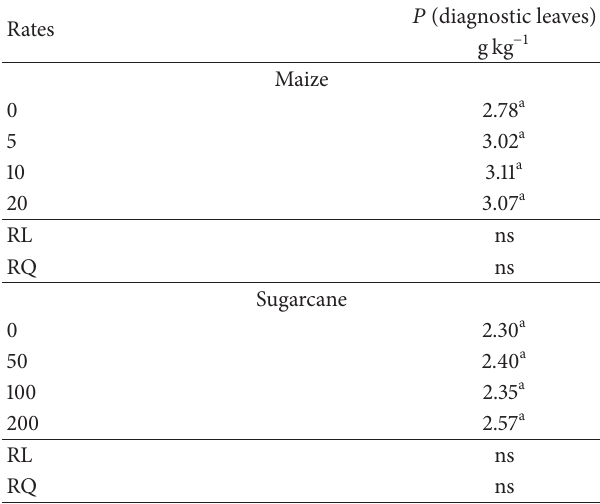
Table 1: Phosphorus concentrations in diagnostic leaves of maize plants grown in a Typic Eutrorthox amended annually with sewage sludge for 13 consecutive years and in diagnostic leaves of sugarcane plantsgrowninaTypicHapludalfamendedoncewithsewagesludge and sludge compost ( 𝑛 = 4